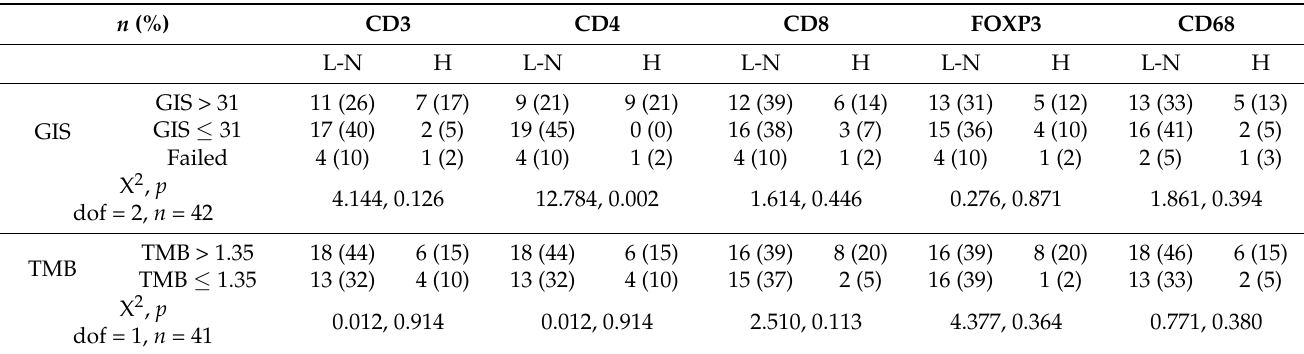
Table 2. Quantification of tumor-infiltrating lymphocytes (CD3+, CD4+, CD8+, CD68+, and FOXP3). Counts are stratified by low–normal (L–N, ≤ 75th percentile) versus high (H, >75th percentile) lym- phocyte count and by median GIS and median tumor mutational burden (31 and 1.35, respectively). Abbreviations: GIS, genomic instability score; TMB, tumor mutational burden.